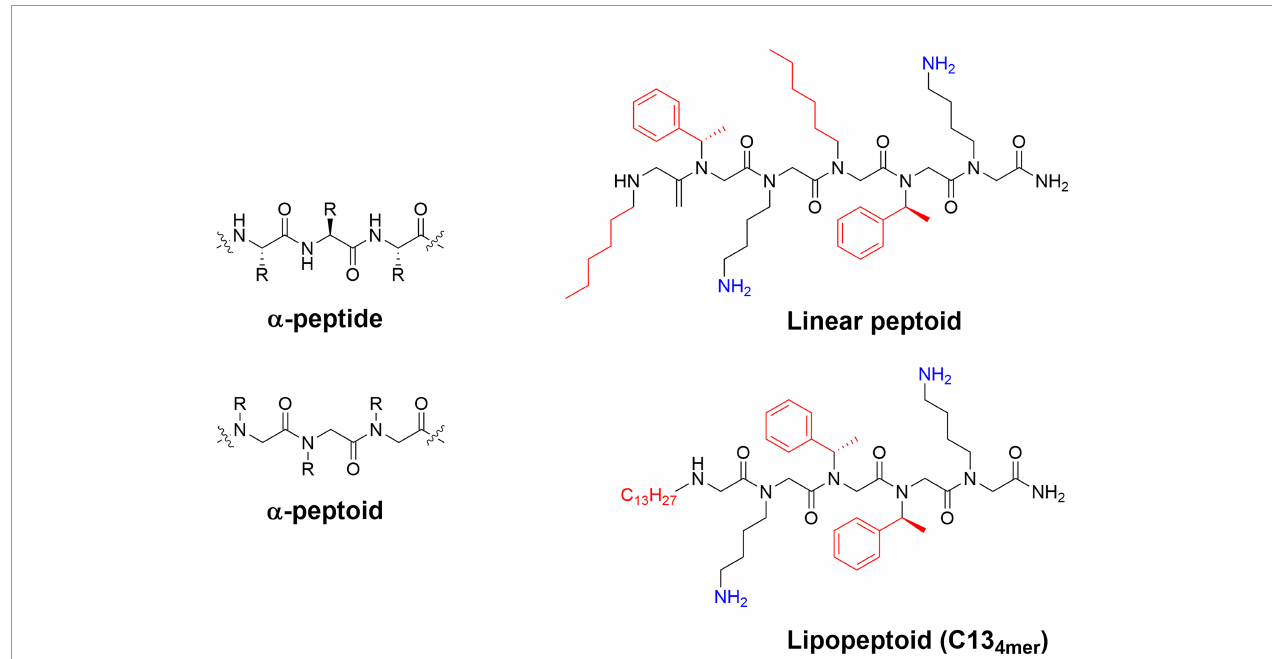
FIGURE 8 | Structure and examples of antimicrobial peptoids. The difference between the backbone of a -peptides and a -peptoids allows for differences in structure and stability of the fi nal compounds. The peptoid scaffold can be used to generate highly active antimicrobial compounds with the linear H-( N he- N spe- N Lys) 2 -NH 2 and the lipopeptoid C13 4mer being active against Mycobacterium tuberculosis and ESKAPE pathogens (73, 116,